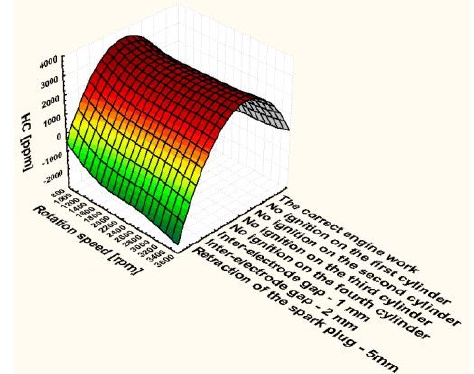
Fig. 23. The content of hydrocarbons emitted by the BMW M10B18 petrol-powered engine